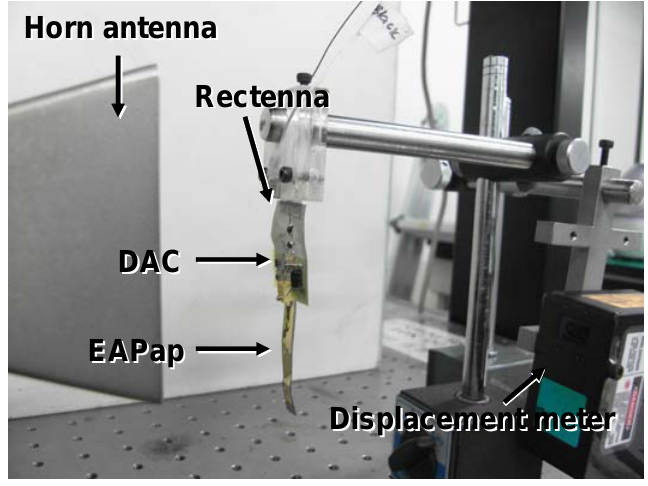
Displacement meter